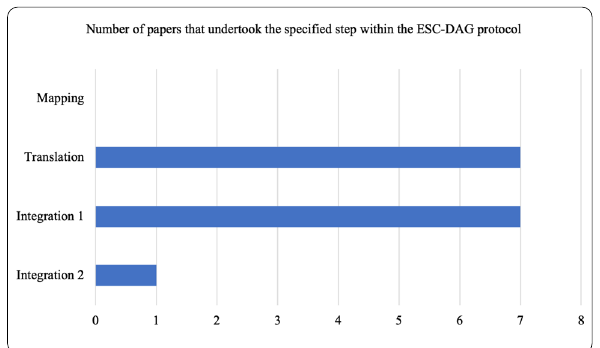
Figure 2. Bar chart demonstrating the number of final papers fulfilling stages laid out in the ESC-DAG protocol. Conclusion: Relatively few studies using DAGs to guide perioperative observational research were identified. The ESC-DAG protocol was not used consistently between studies. Greater adherence to this protocol in the perioperative literature will ensure DAG construction is consist- ent and